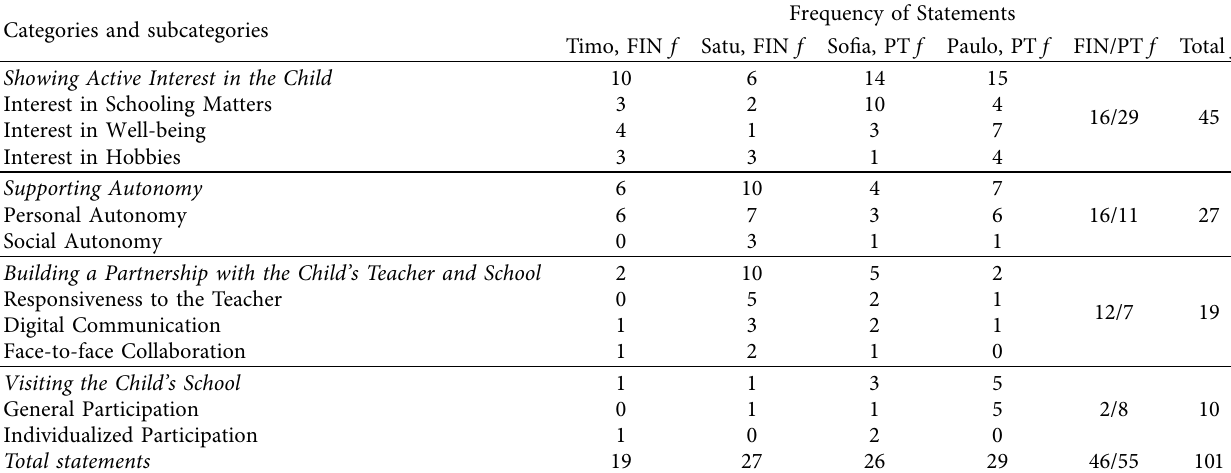
Table 2: Frequencies ( f ) of categories and subcategories of exemplar parents’ engagement